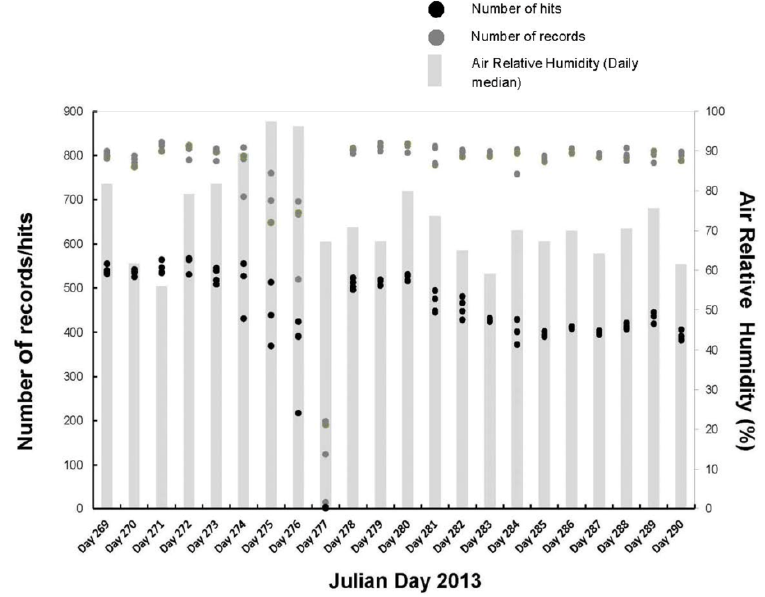
Figure 2. Time-series of the number of records and hits registered by the VEGNET IML during September 26 and October 17,